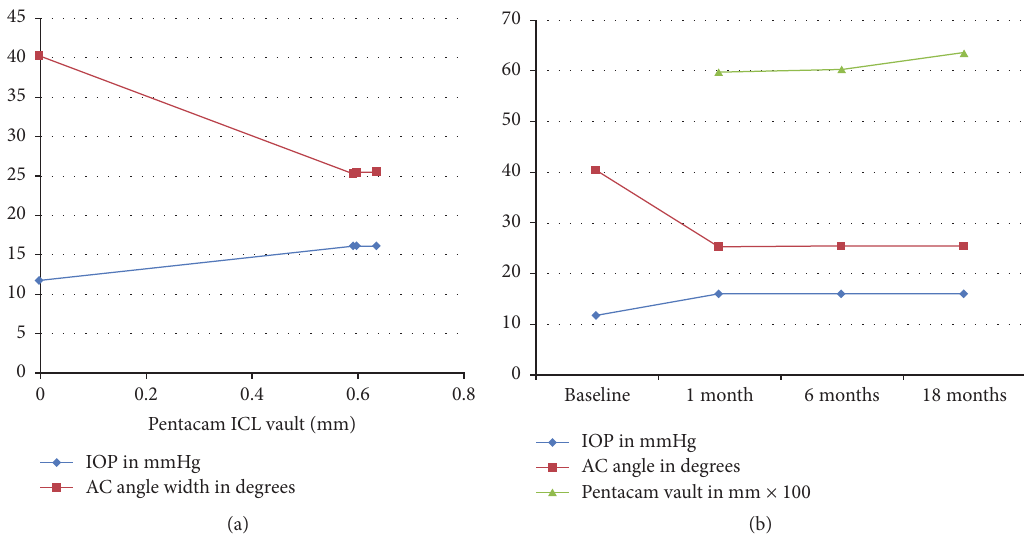
Figure 3: Changes in Pentacam AC angle width, Pentacam ICL vault, and IOP at different time